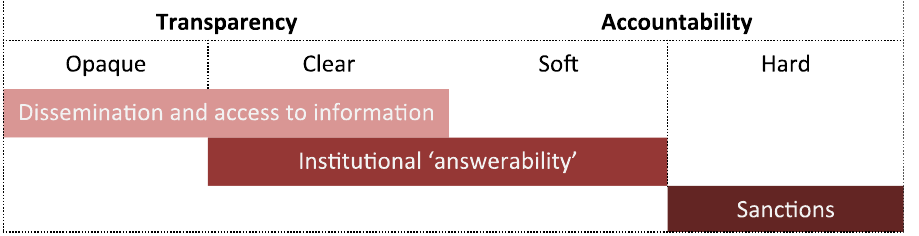
Figure 5. The relationship between transparency and accountability (Fox 2007, p.